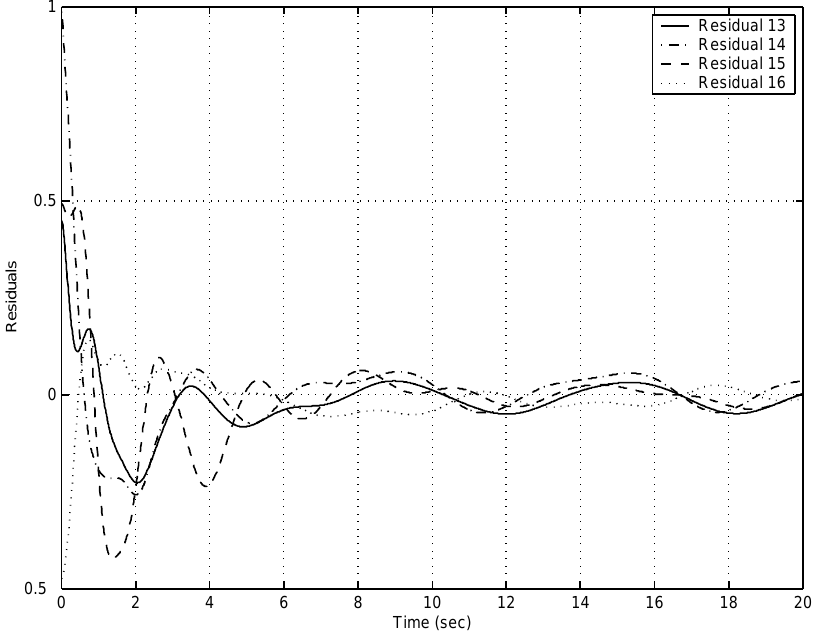
Fig. 18. Residuals 13–16 for 12 mode simulation with δ 1 = 0 . 01